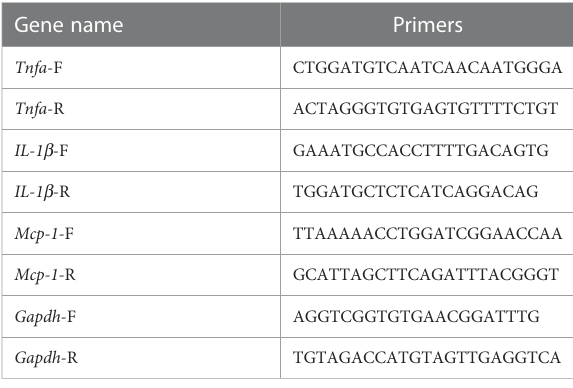
TABLE 2 Sequences of the